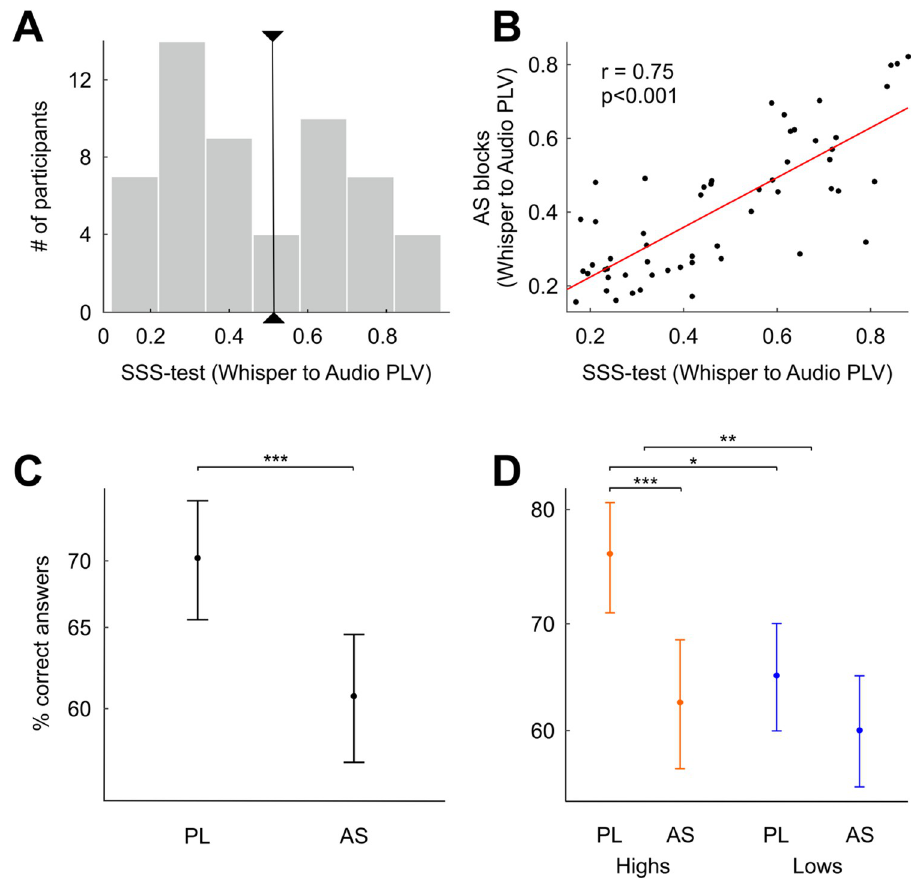
Fig 2. AS modulates only high synchronizers’ performance. (A) SSS test outcome. Histogram of the PLVs (measure of speech-to-speech synchrony; see Methods) between the envelope of the perceived and produced speech signals, band-pass filtered at 3.5 to 5.5 Hz. Black line, critical value separating high and low synchronizers ( N = 55; see Methods). (B) Participants’ PLV during AS as a function of the PLV from the SSS test. Red line represents the correlation of the data. (C) Percentage of correct responses during PL and AS across the entire sample. (D) Percentage of correct responses during PL and AS for the low (blue) and the high (orange) synchronizers. � p < 0.05, �� p < 0.01, ��� p < 0.001 Linear mixed model results. Dots: model predicted group means. Bars: 95% confidence interval. Data for Fig 2A and 2B can be found in S1 Data. Data for Fig 2C and 2D can be found in S2 Data. AS, articulatory suppression; PL, passive listening; PLV, phase locking value; SSS test, Spontaneous Speech Synchronization test.